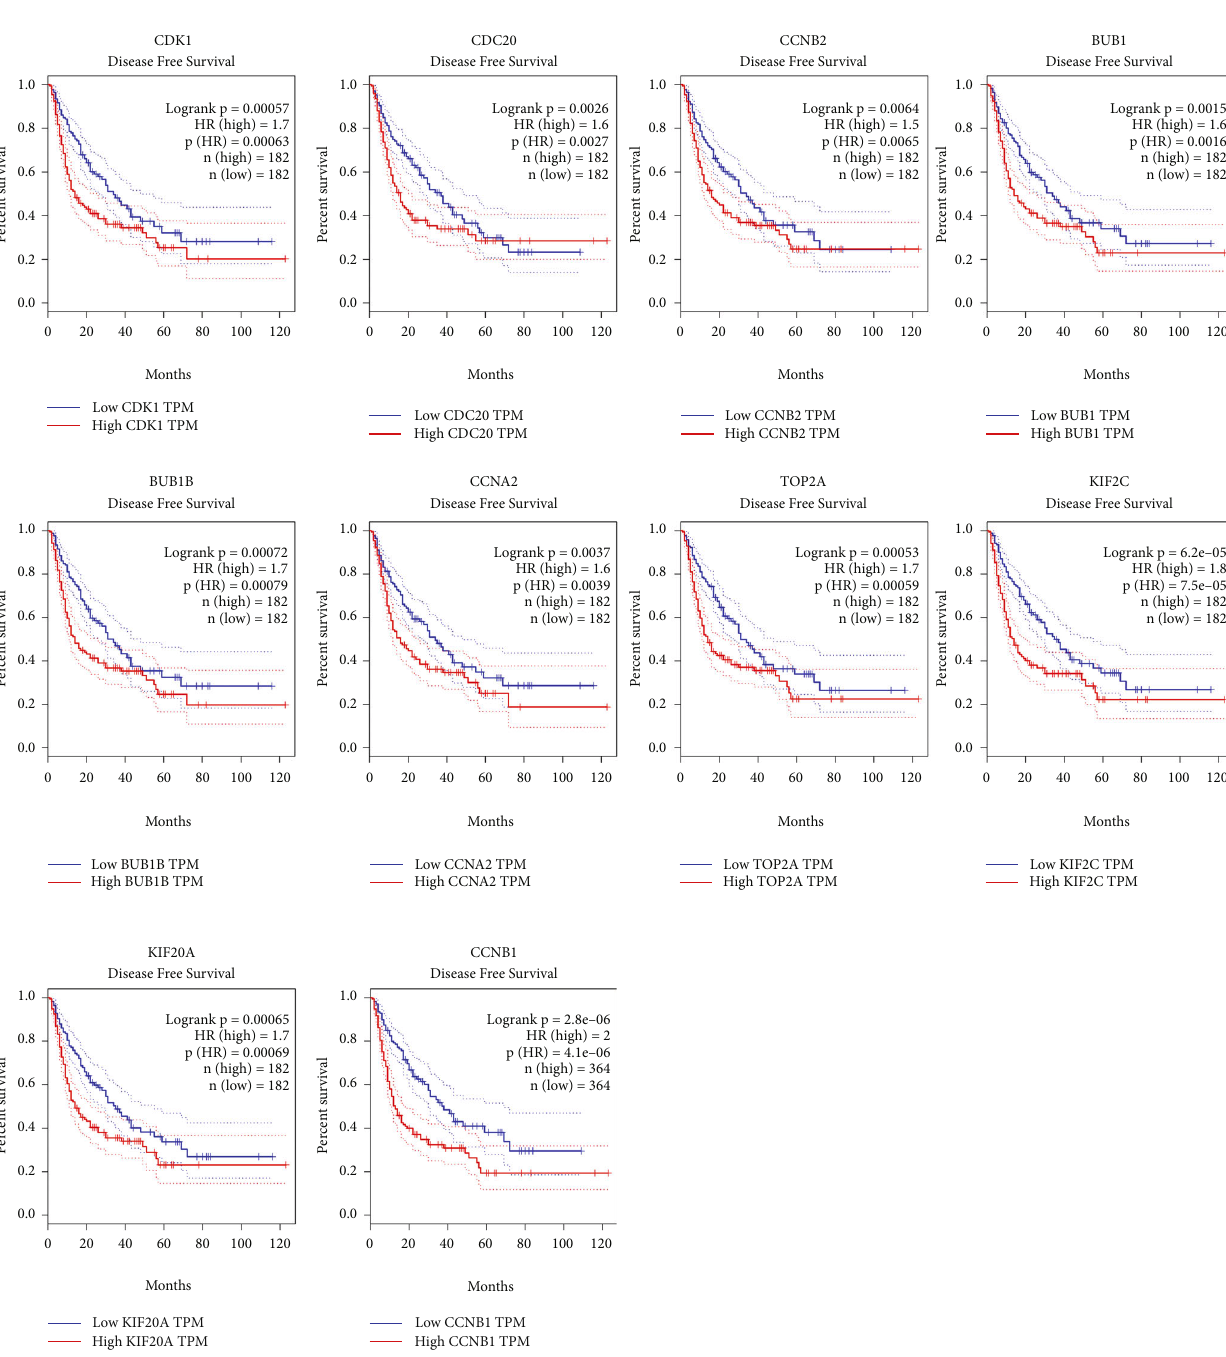
Figure 7: The link between CDK1, CDC20, CCNB2, BUB1, BUB1B, CCNA2, TOP2A, KIF2C, KIF20A, and CCNB1 expression and DFS of HCC patients was determined by